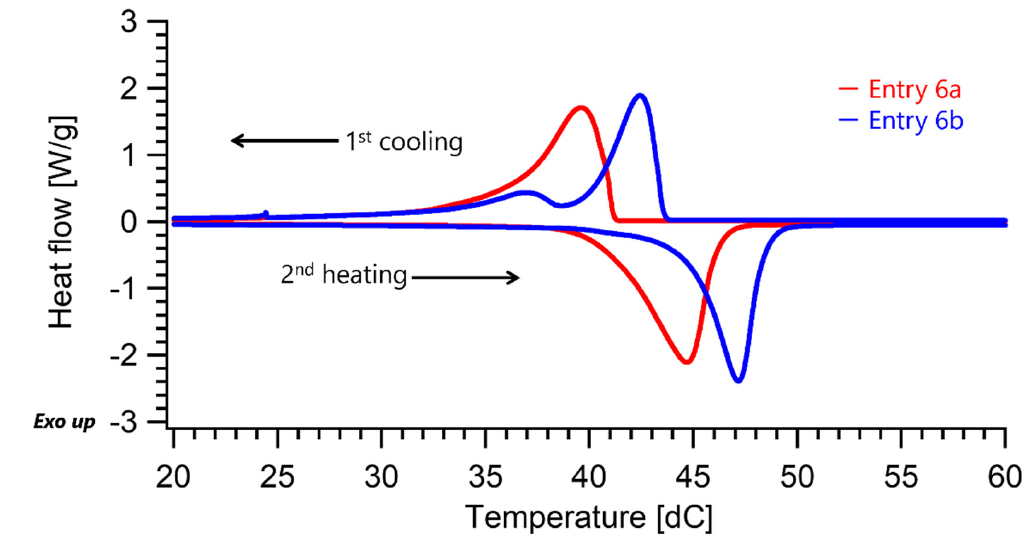
Figure 6. DSC curves before (red line, Entry 6a) and after TTC removal from PSA4.9k (blue line, Entry 6b). The heat- ing/cooling rate was 5 °C / min.